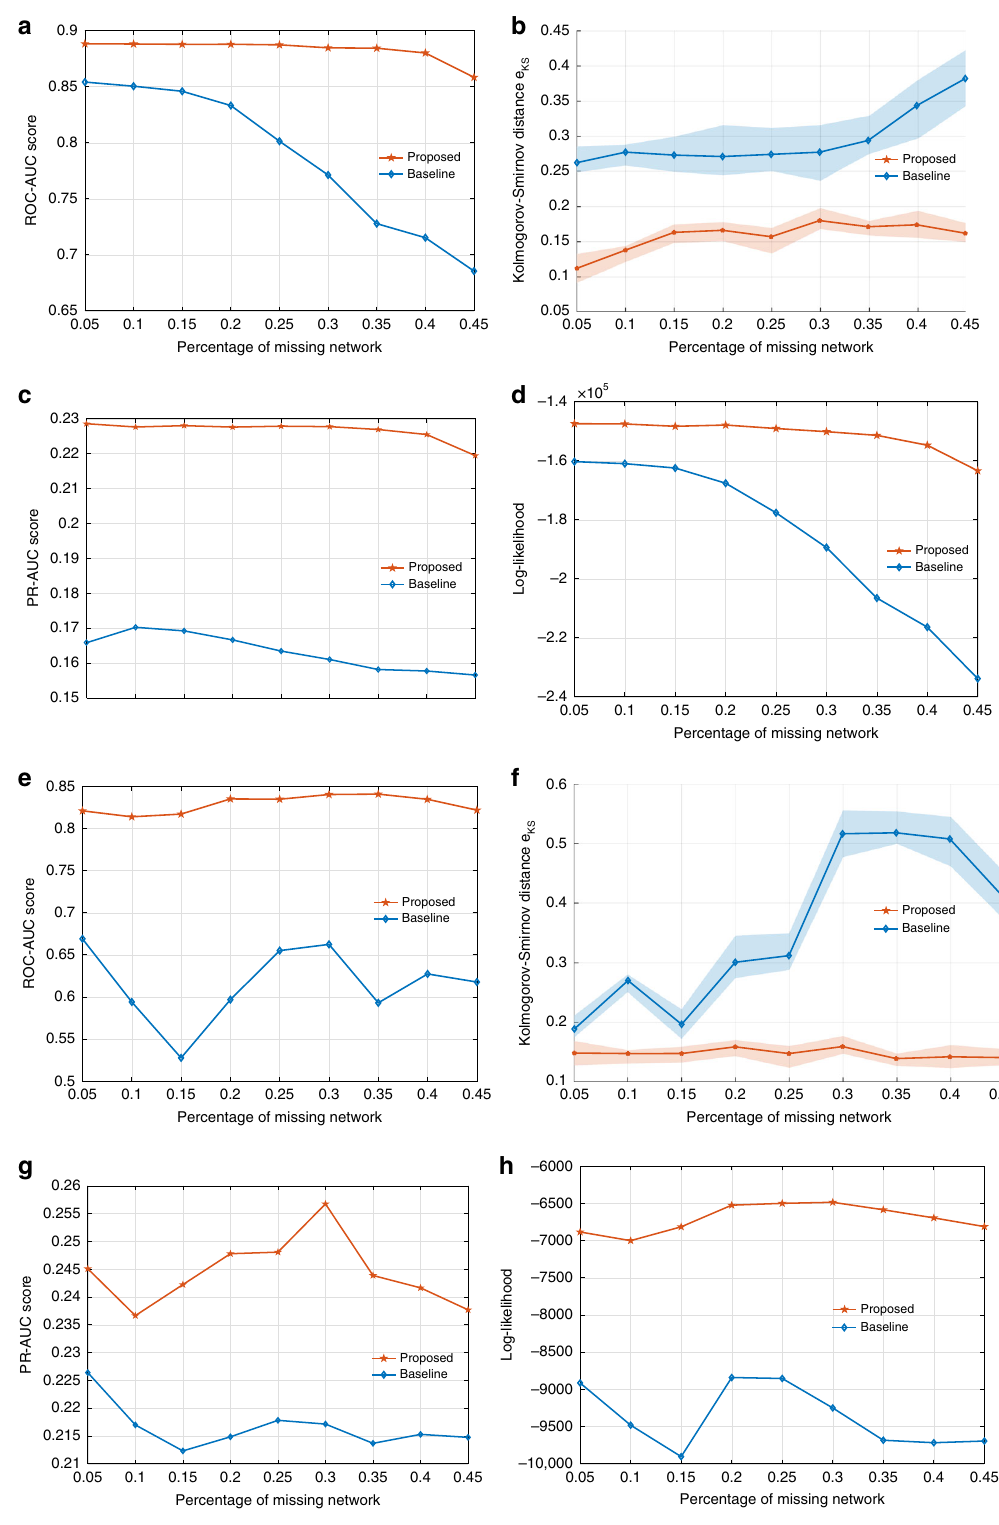
Fig. 4 Recover the human protein complex interaction network ( a – d ) and brain consensus connectome ( e – h ). a , c , e , g Compare the capability to infer the missing network via AUC score. b , f Goodness-of-the- fi t comparison as reported by Kolmogorov – Smirnov distance between the true degree distribution and the one retrieved by baseline and proposed methods. d , h Quanti fi cation of the capability of both methods to recover the global property of the protein complex interaction via